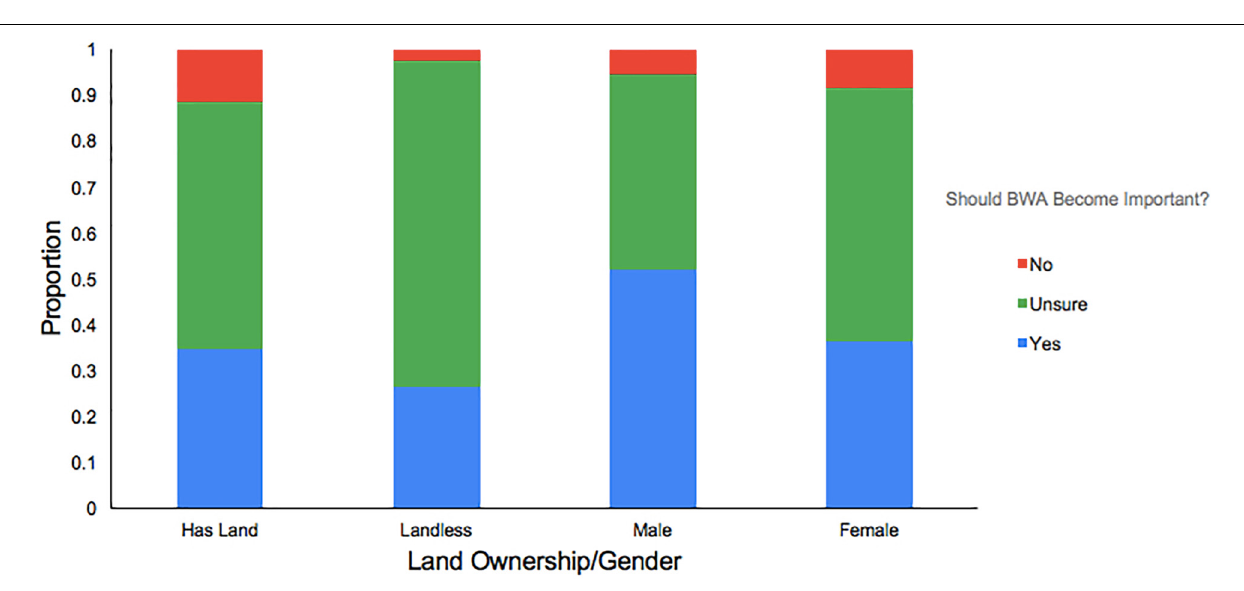
FIGURE 3 | Interest in brackish water aquaculture (BWA) by land ownership category and